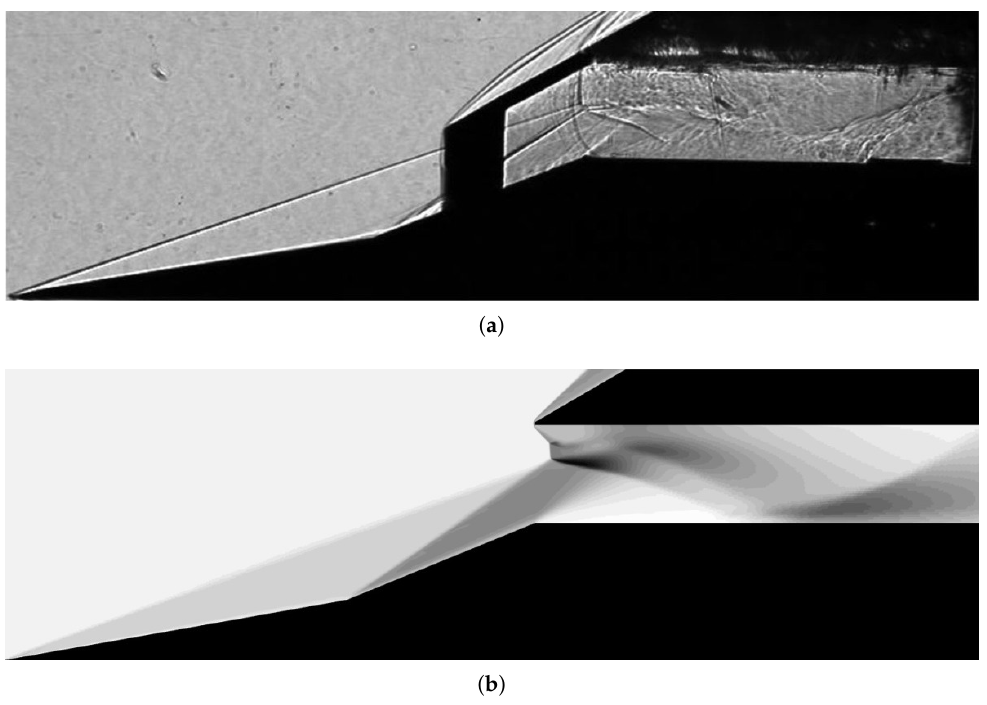
Figure 3. Comparison between the experimental Schlieren density and the Reynolds-averaged density field a hypersonic intake at Mach 5 and Reynolds 2.3 density [49]; ( b ) Reynolds-averaged density